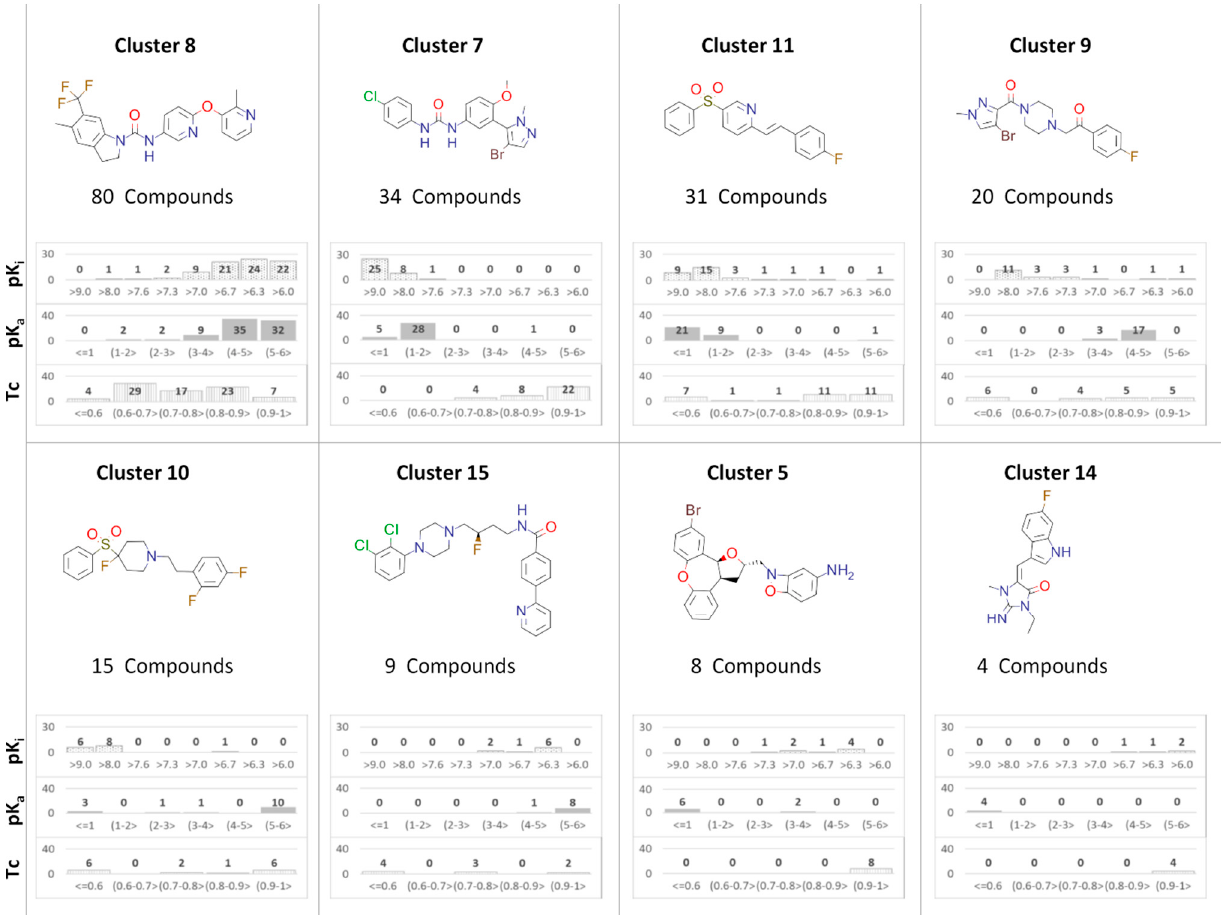
Figure 3. Distribution of selected compound properties (pK i , predicted pK a and Tc values towards cluster centroid) for the most populated clusters of non-basic 5-HT 2A R ligands.